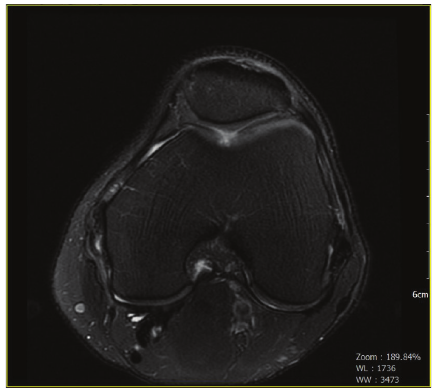
Figure 1: Preoperative radiograph. Multiplanar, multisequential images were obtained through the left knee on a 1.5 Tesla MRI scanner. Mild patellofemoral joint osteoarthritis. A focal region of grades III-IV chondromalacia overlying the central femoral trochlear